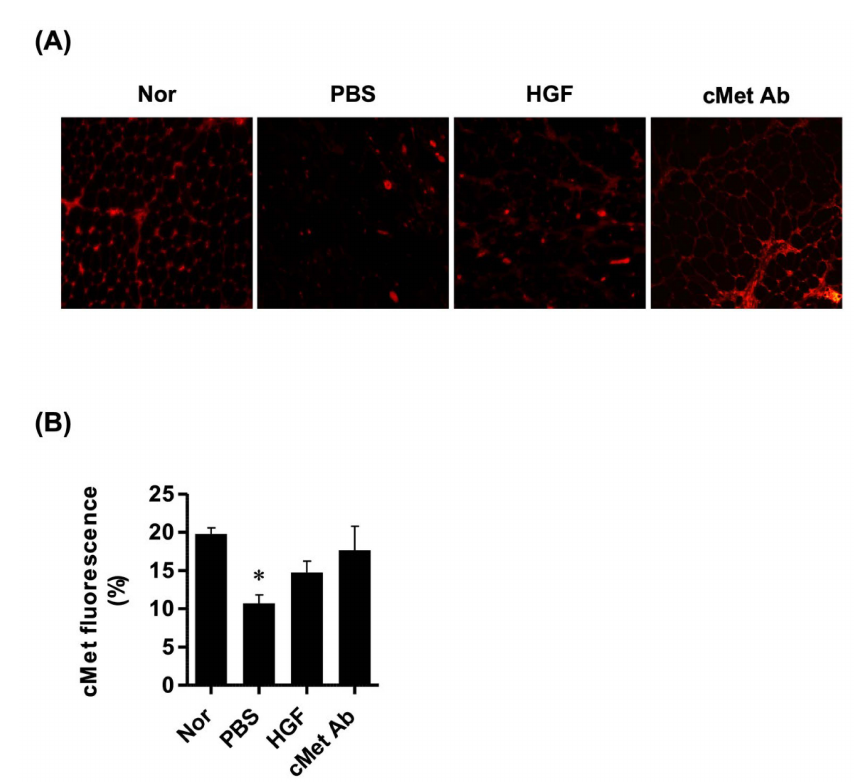
Figure 3. Analysis of c-Met expression in laryngeal muscles. ( A ) Representative images of c-Met staining (original magnification: 200 × ). ( B ) Relative intensity of c-Met fluorescence. * p < 0.05 compared to Nor (normal).